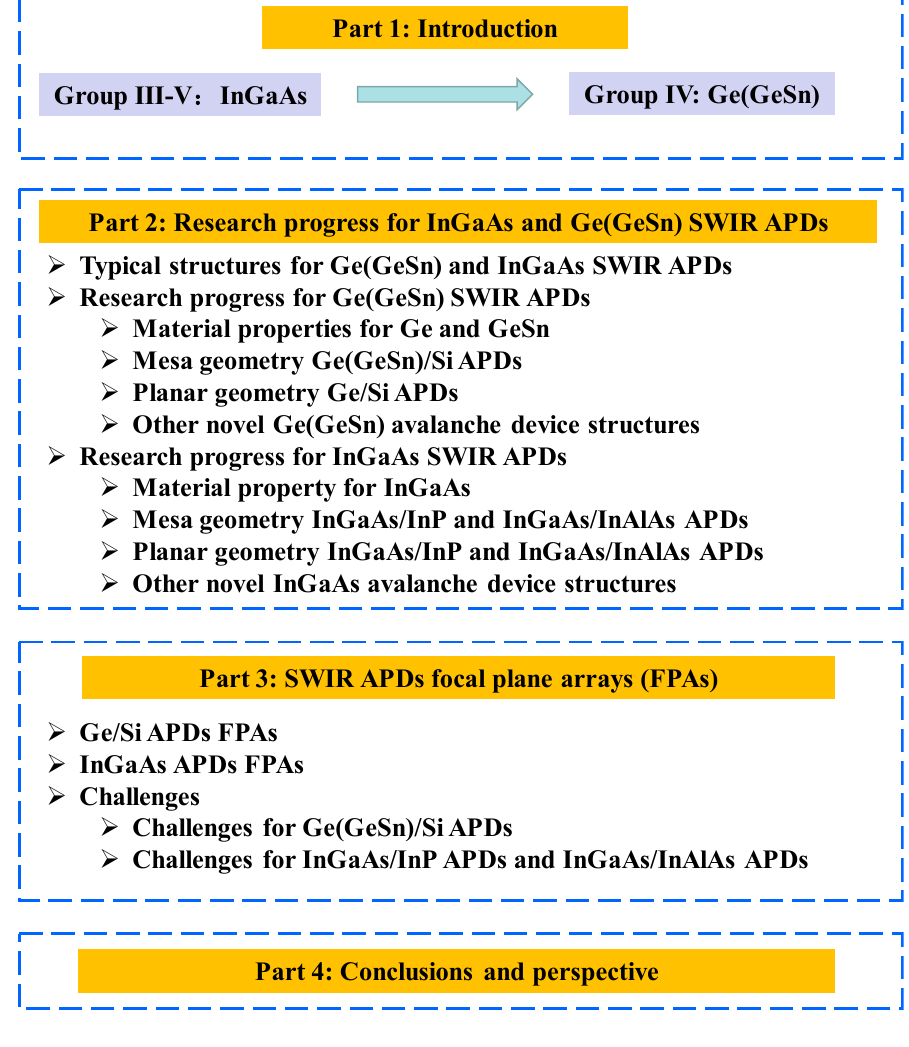
Figure 3. Outline of this review article.